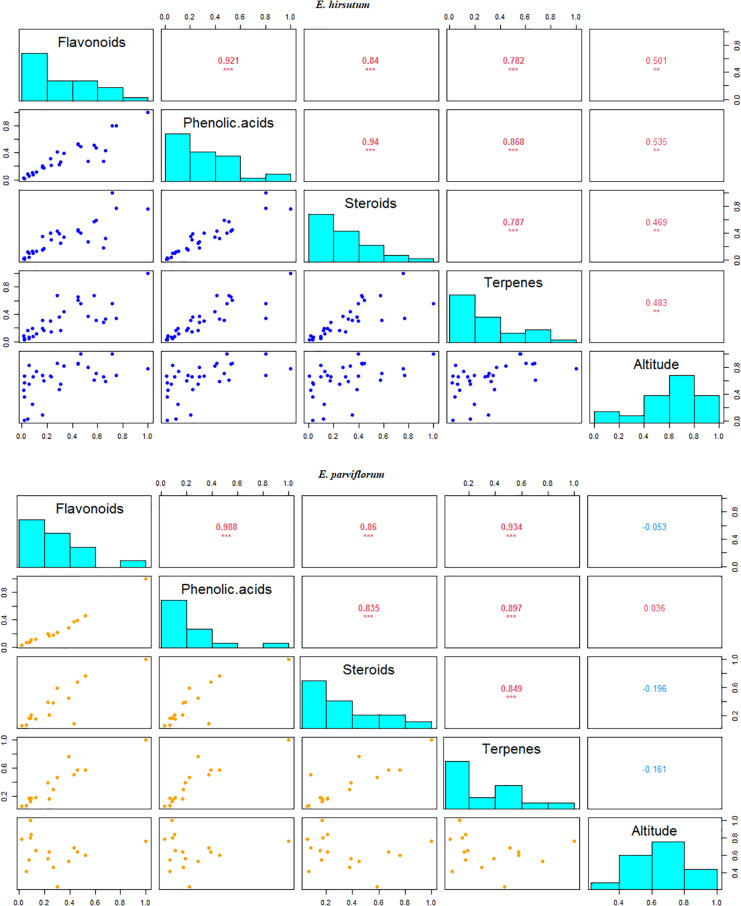
Correlation between the major groups of secondary metabolites and altitude in E. hirsutum and E. parviflorum. The numbers in upper diagonal represent correlation coefficient; levels of significance at **0.01 and ***0.001.